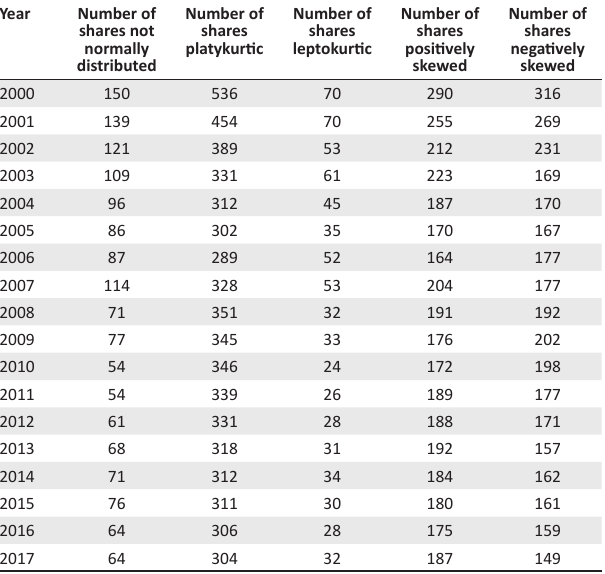
TABLE 2: Descriptive statistics of shares.